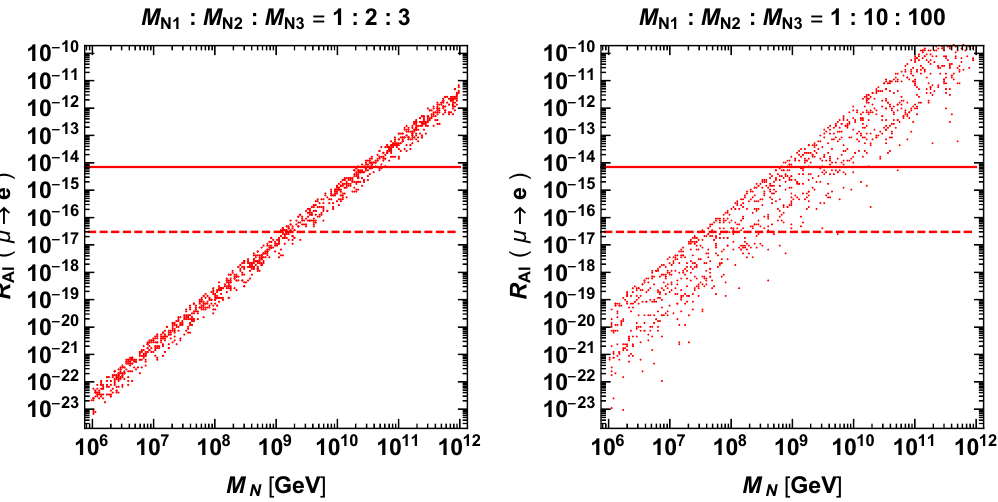
Figure 4 . R Al ( µ → e ) is shown for model A. The parameters are same as figure 3.